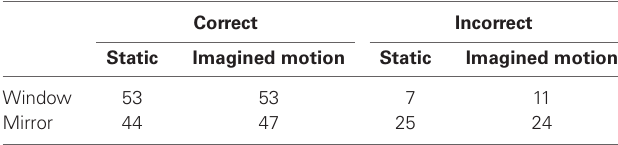
Table 2 | Number of correct carriages (out of 20 × 3 = 60) selected in each condition, and also number of incorrect carriages (out of 20 × 5 = 100) selected in each condition